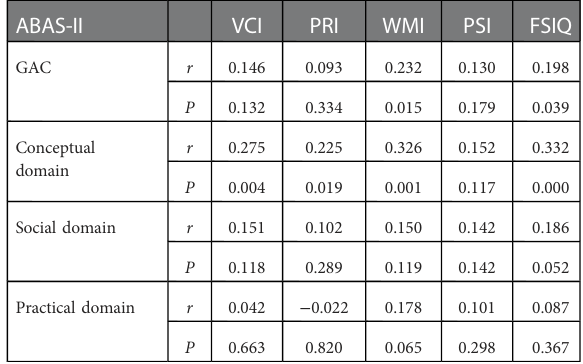
TABLE 5 Pearson correlations between intelligence pro fi les and adaptive behaviors in the DSLDs